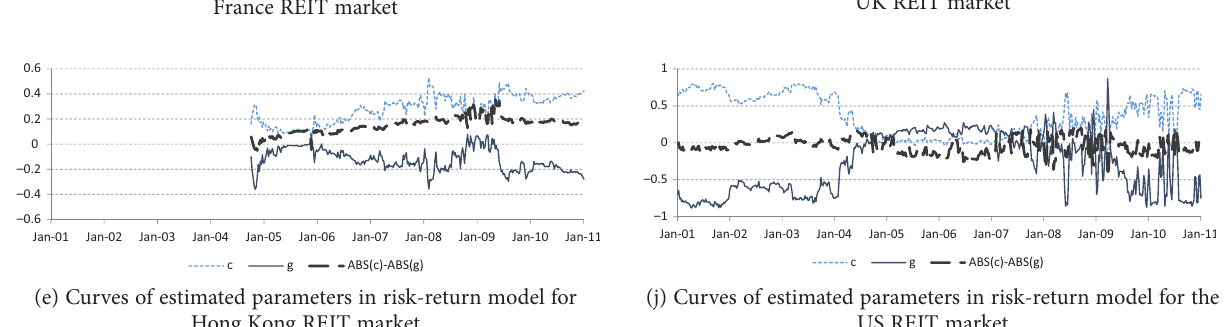
Figure 3. Estimated parameters in risk-return model for 10 global REIT